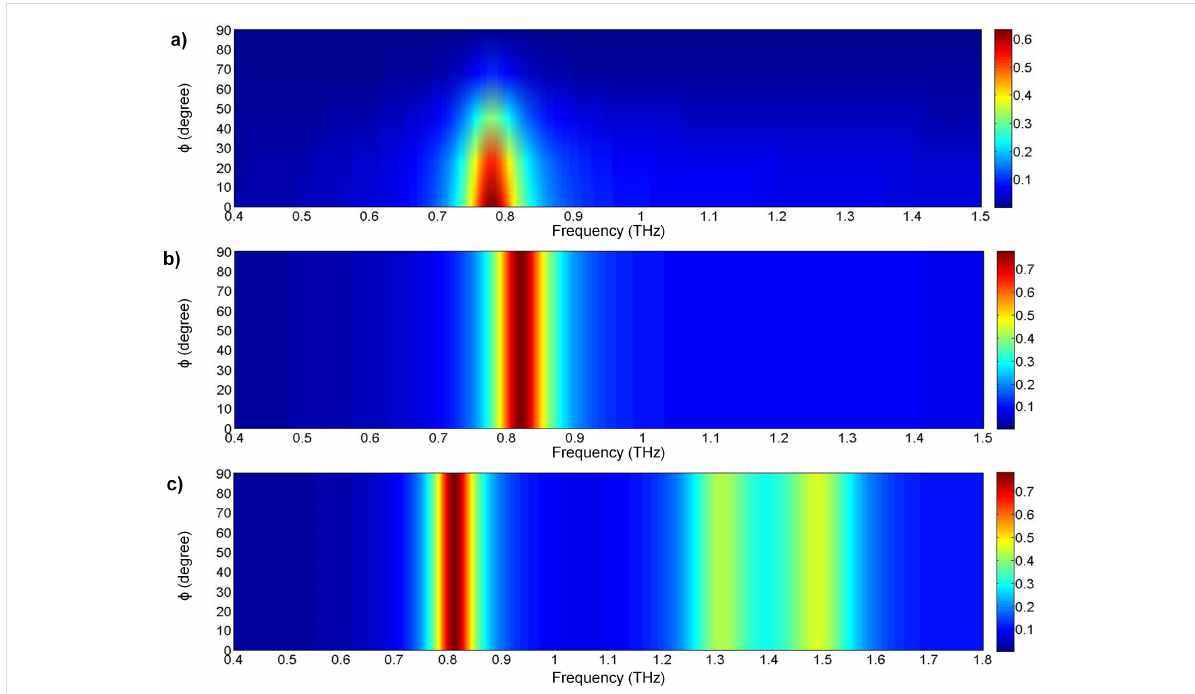
Figure 7: The simulation result of the absorbance difference for polarization angles from 0° to 90° of: a) Cut-wire sandwich structure, b) cross-shaped sandwich structure, and c) star-shaped sandwich structure.